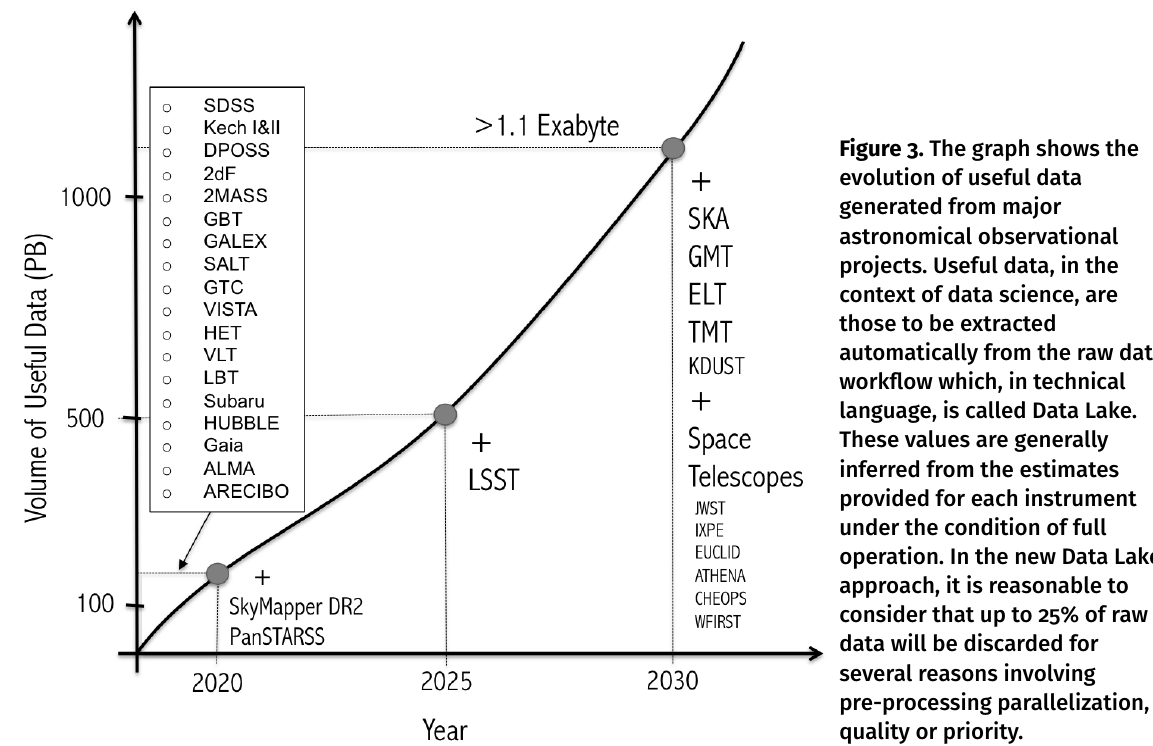
Figure 3. The graph shows the evolution of useful data generated from major astronomical observational projects. Useful data, in the context of data science, are those to be extracted automatically from the raw data workflow which, in technical language, is called Data Lake. These values are generally inferred from the estimates provided for each instrument under the condition of full operation. In the new Data Lake approach, it is reasonable to consider that up to 25% of raw data will be discarded for several reasons involving pre-processing parallelization, quality or